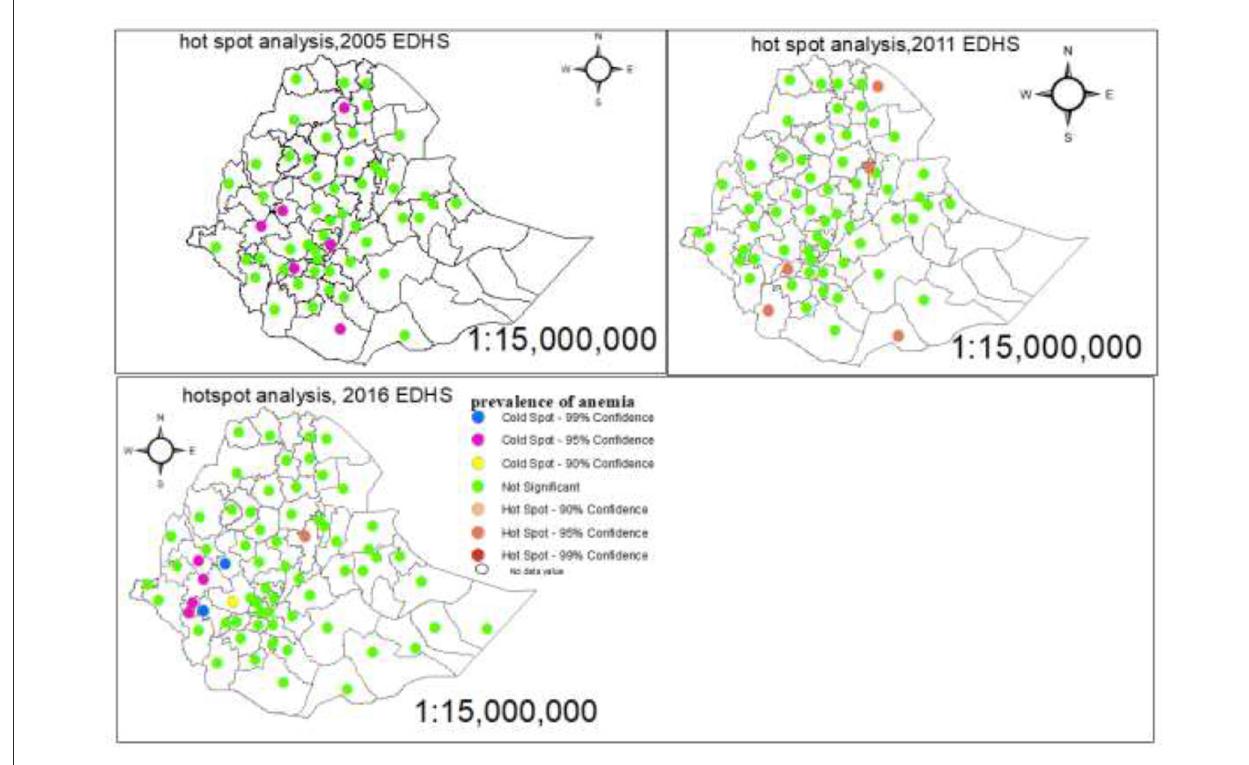
FIGURE7 Hot spot and cold spot identification of anemia among pregnant women in Ethiopia administrative zones.